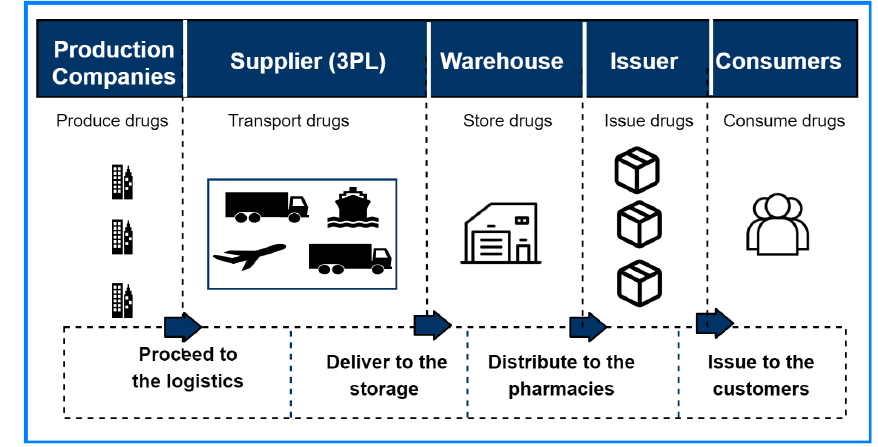
Figure 1. Use case